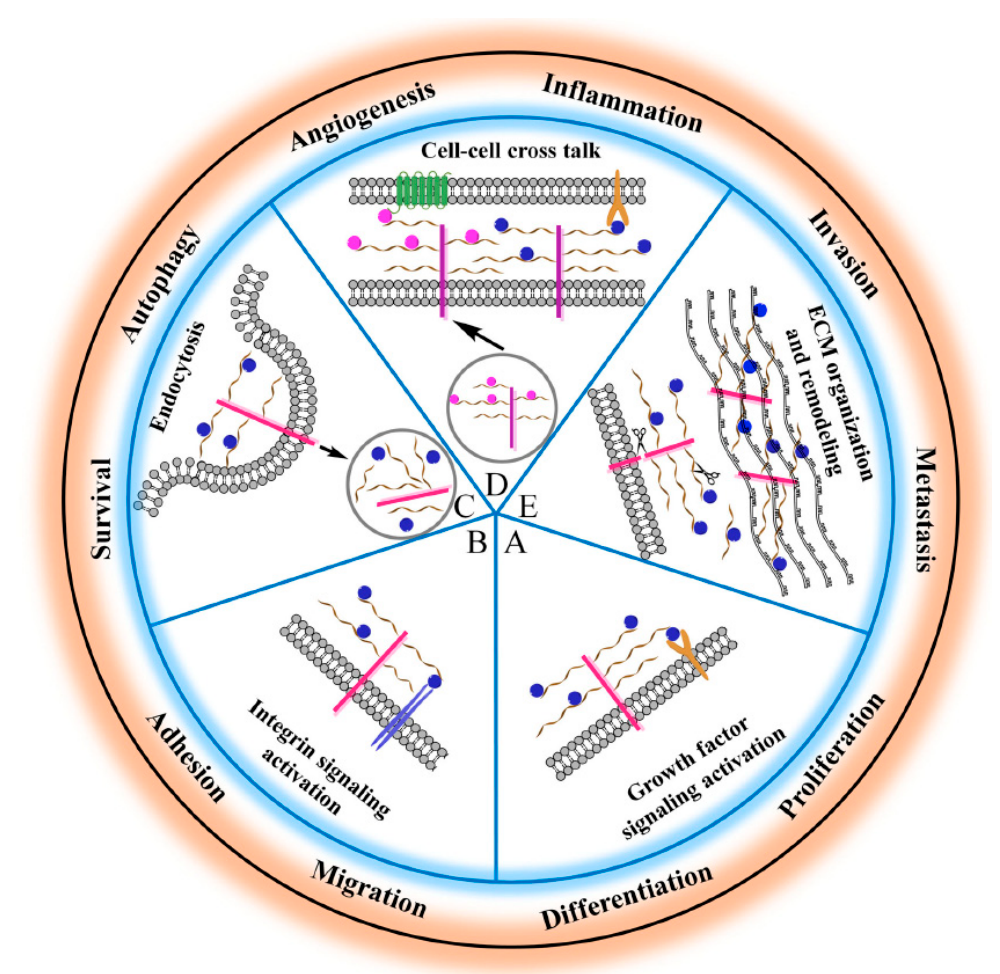
Figure 1. Schematic representation of the main HSPG functions relevant to cancer cell biology. ( A , D ) HSPGs serve as a signaling co-receptor for growth factor activity, allowing a proper presentation of them to their cognate receptors, on the same or adjacent cells. In panel D, transcellular transport of a ligand (i.e., chemokine) bound to HS chains and its presentation at the cell surface is also shown. ( B , D ) HGPGs bind integrins modulating their downstream signaling that regulates cytoskeleton organizationaswellascelladhesion, spreadingandsensingmechanicalstress. ( C )HSPGsactasendocytic receptors and undergo constitutive as well as ligand-induced endocytosis: exosomes, cell-penetrating peptides, polycation–nucleic acid complexes, lipoproteins, growth factors, and morphogens enter cells through this mechanism. Internalized cargo can be sorted for lysosomal degradation, escape into the cytosol, or recycle back to the plasma membrane. ( E ) HSPGs are critical determinants of extracellular matrix (ECM) assembly and remodeling. If the HSPGs perlecan, agrin, and collagen type XVIII are directly secreted in the ECM, cell surface-tethered HSPGs (syndecans and glypicans) undergo proteolytic cleavage of their ectodomains or to cleavage of HS chains by heparanases and their truncated forms can be distributed in the ECM. Here, HSPGs act as a reservoir of growth factors and supply them to target cells when needed. Otherwise, they may act as a barrier for growth factors, by preventing their passive diffusion over longer distances, instead of confining them to the vicinity of producing cells. Overall, HSPGs control fundamental cellular processes (i.e., cell adhesion, migration, etc.) whose dysregulation underlies tumor development and